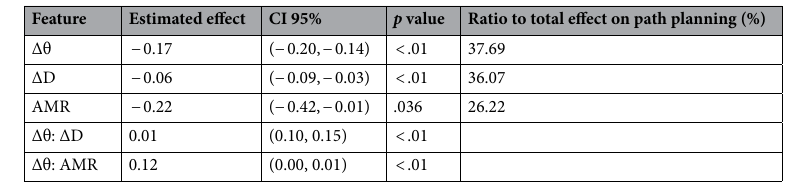
Table 4. Starting with the right foot decreased to 52% when the target was placed on the left side of the bookcase shelf. The Pearson correlation coefficient between the starting foot and selected path for different obstacle and target position was 0.53 ( p = .03).